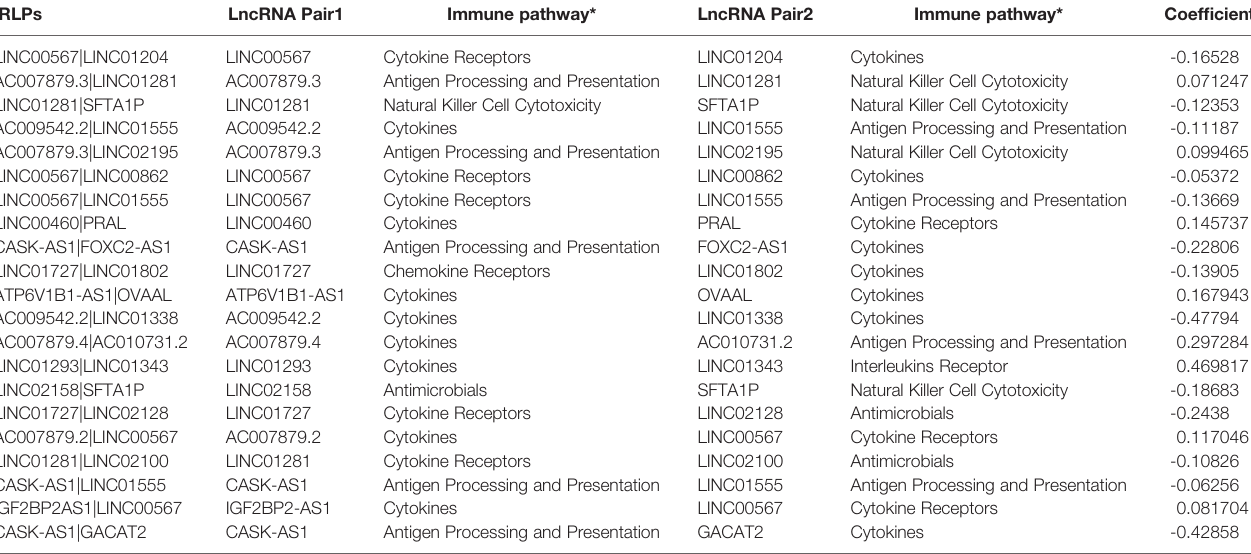
TABLE 1 | Information of 21 IRLPs.